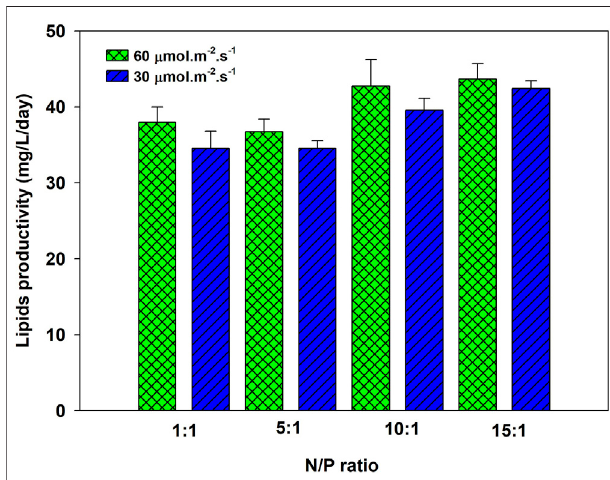
FIGURE 3 | Lipid productivity of Parachlorella kessleri HY-6 at different N/P ratios at 60 μ mol m − 2 s − 1 and 2.0% CO 2 .